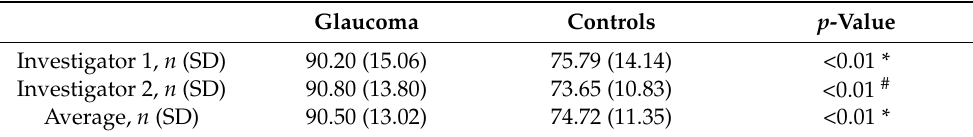
Table 2. HRS counts according to investigator 1 and investigator